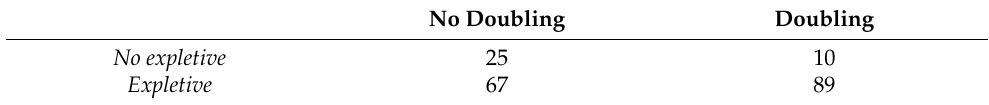
Table 4. The number of dialects exhibiting expletives (with weather verbs) and doubling of the wh element who. Dataset: Manzini and Savoia (2005) and selected data points from the ASIt database. No Doubling Doubling No expletive 25 10 Expletive 67 89